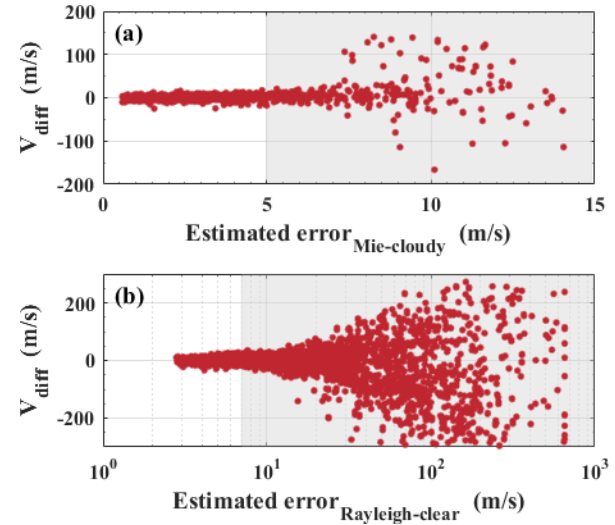
Figure 4. Difference between the Aeolus HLOS and RWP HLOS wind components as a function of estimated errors for (a) Mie- cloudy winds and (b) Rayleigh-clear winds. Gray areas indicate the data with errors larger than 7m/s (Rayleigh) or 5m/s (Mie), which in the present analysis are considered invalid